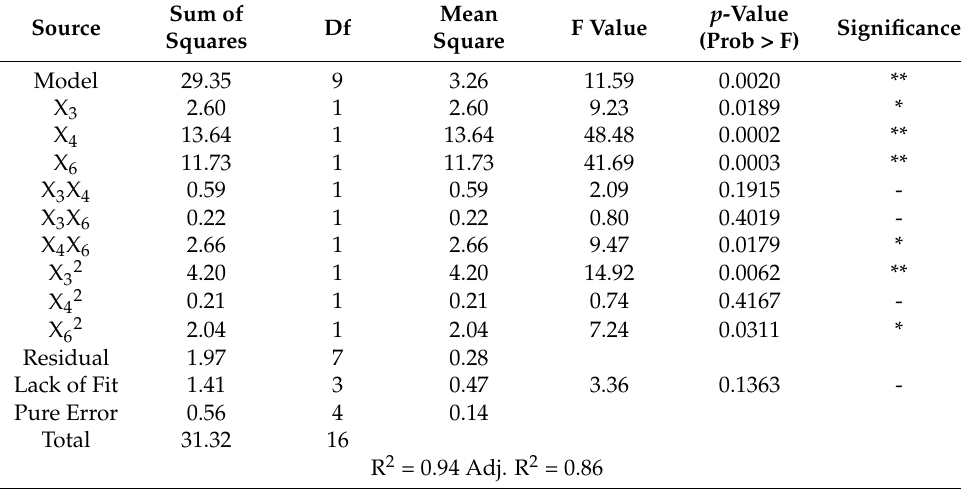
Table 5. ANOVA for response surface quadratic model of membrane